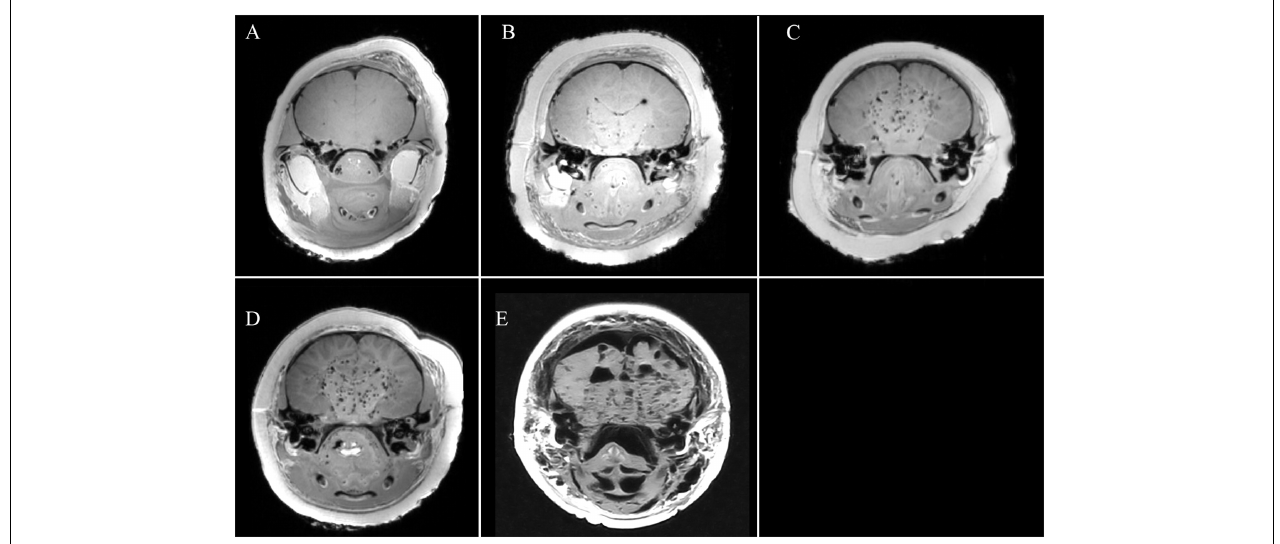
FIGURE 2 | T1w PMMRI of the cetacean brain demonstrating five criteria of analysis: (A) clearly depicted; (B) indicated; (C) partly indicated; (D) barely identifiable; (E) not